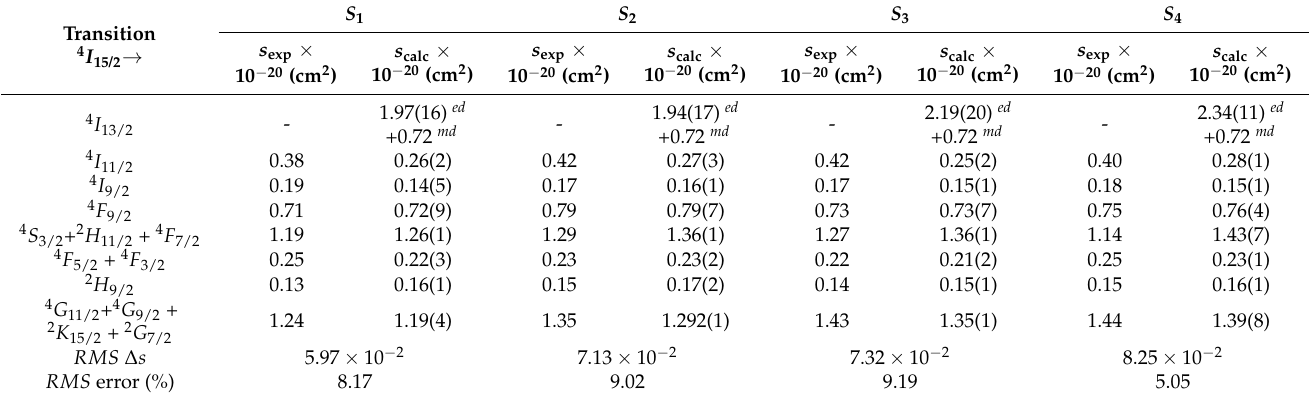
Table 2. Values of the measured and calculated absorption line strengths of Er 3+ in the YAG (YSAG) ceramic samples at 300 K; ed is electric dipole transition, md is magnetic dipole